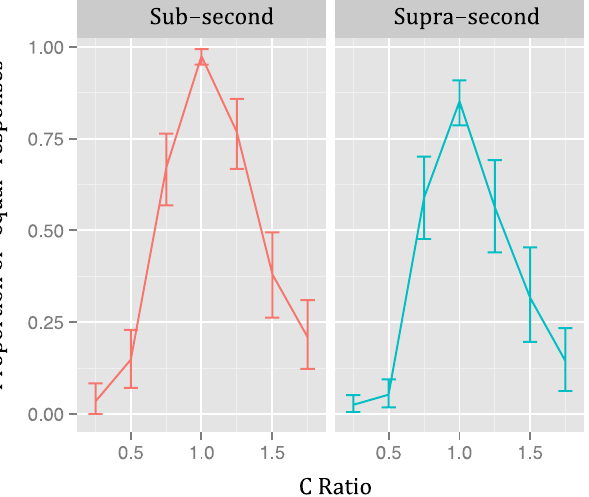
Figure 2. Temporal generalization gradients of Experiment 1 (linearly spaced ratios). Proportion of “equal” responses as a function of the ratio of the comparison duration when collapsing presentation orders Vertical lines represent 95% confidence levels.